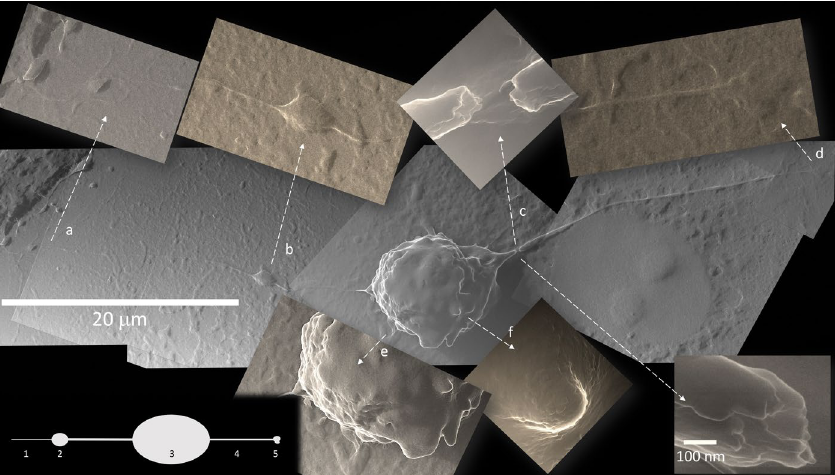
Figure 4. TNT from a polarized infected cell. Some infected cells start to bulge and detach from the floor, while emitting TNT in a specific bipolar fashion. An asymmetry in these bipolar cells is often noted, so that there is a growth cone (b, 2) on one side, that may emit a slight prolongation of variable length (a, 1), while the opposite TNT (4) ends with a polymorphic bulge (d, 5). Breakages at TNT origin close to the cell body visualize an inner content of cylindrical structures of about 25 nm in diameter, suggestive of microtubules (c). A corrugated surface (e) and apoptotic bodies (f) are specific to this infected cell stage (All photomicrographs at 10,800×; apart from c top, 135,000× and c bottom 270,000×).